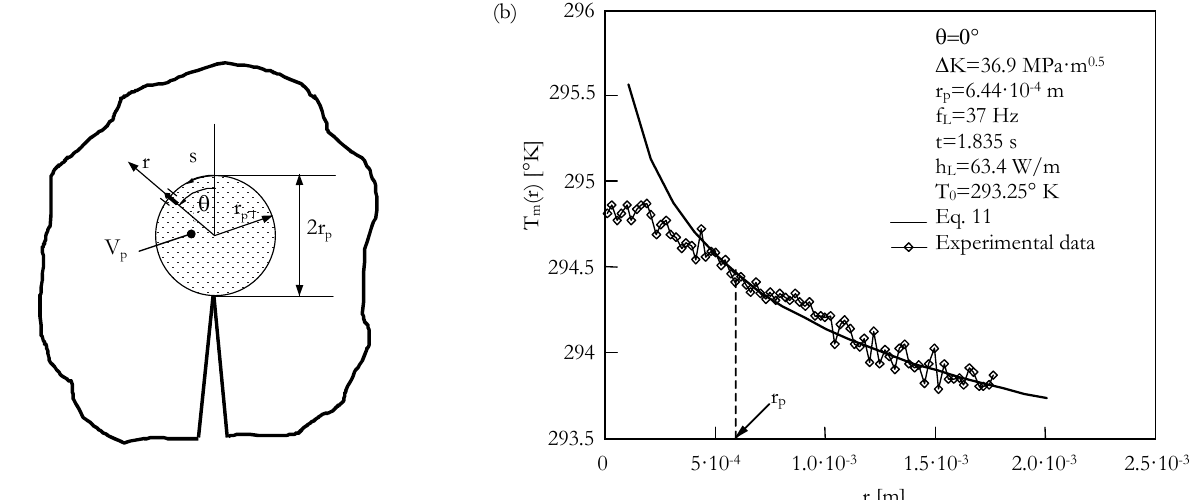
Figure 6: a) Cyclic plastic zone V p and (b) comparison between experimental and theoretical radial temperature